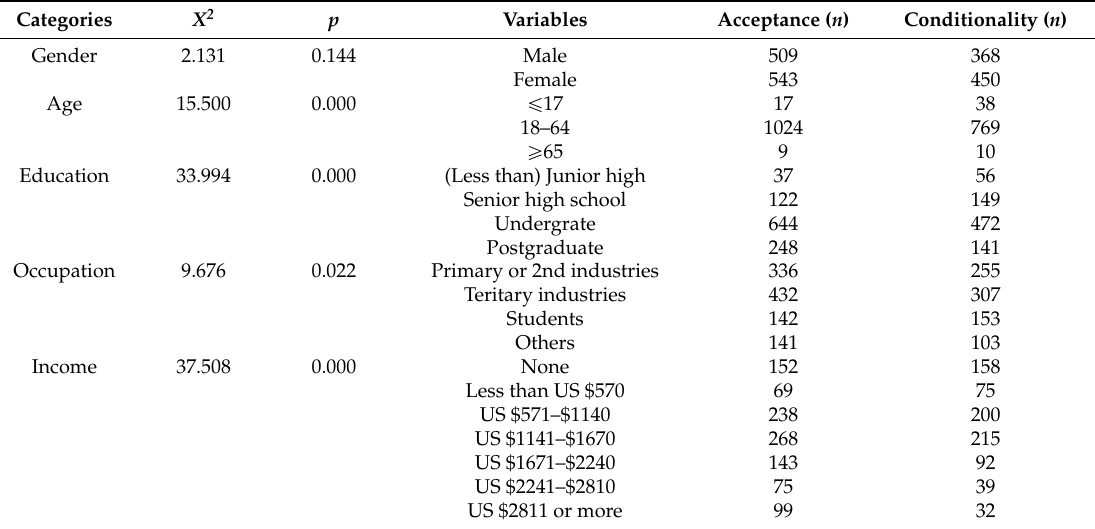
Table 3. Sociodemographic characteristics of each